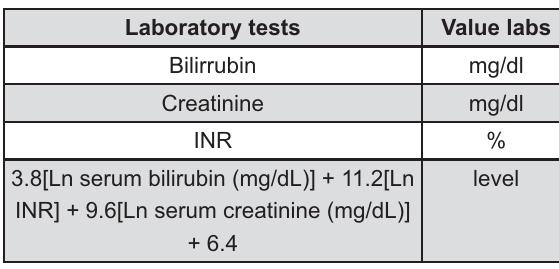
Figure 1- Model for end-stage liver disease (MELD)